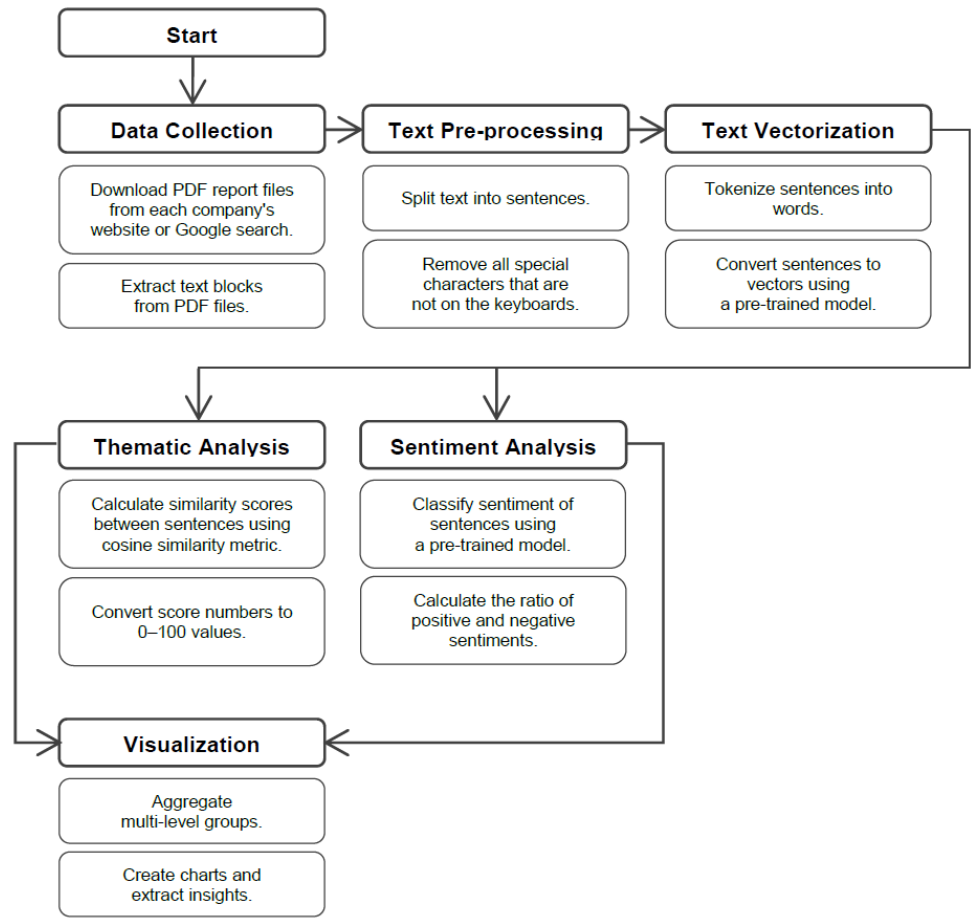
Figure 1. Workflow of overall analysis.